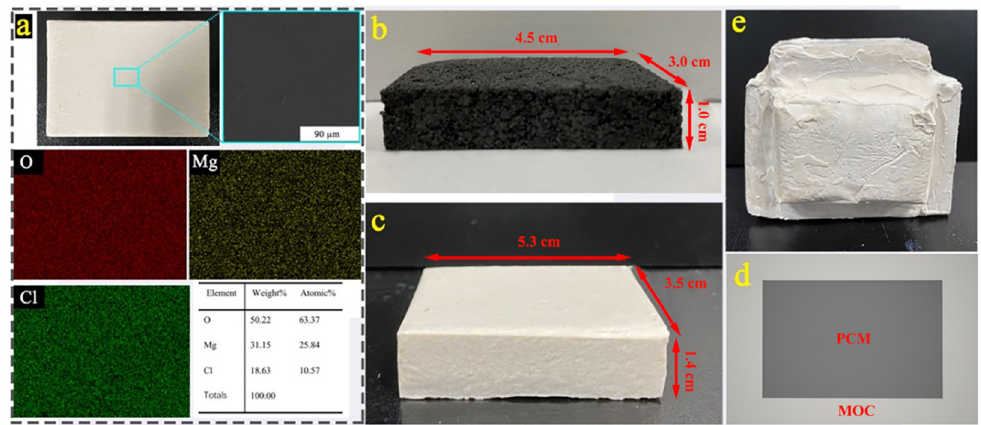
Figure 7. ( a ). SEM and EDS spectra of magnesium oxychloride cement (MOC); ( b ) digital picture of PCM block; ( c ) digital picture of MOC-PCM block; ( d ) top perspective view of MOC-PCM block; ( e ) house-like with a certain space.